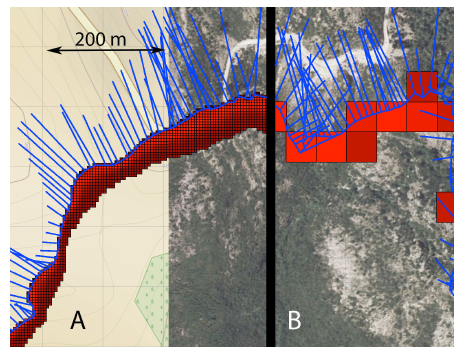
Figure 3. Aullene’s fire, markers (blue) and heat fluxes above 30 kWm − 2 at fire resolution (5 m) ( A ) used to force the atmospheric surface fields (resolution 50 m) ( B ).